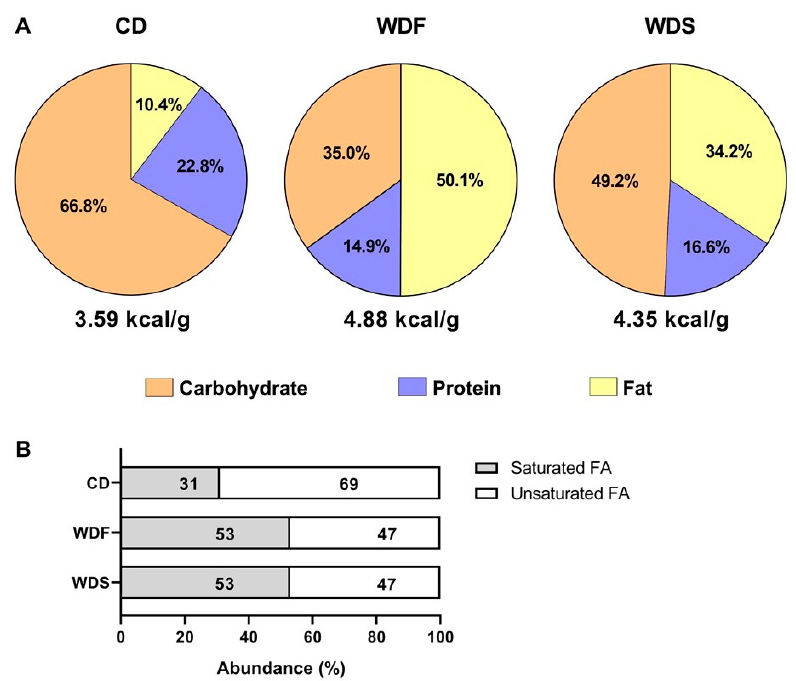
Figure 2. Nutritional composition of diets used in the study. ( A ) Percentage of total calories from carbohydrate (orange), protein (blue), and fat (yellow) in the Control diet (CD), Western diet fat (WDF), and Western diet sugar (WDS). ( B ) Relative abundance of saturated and unsaturated fatty acids (FA) in all diets.